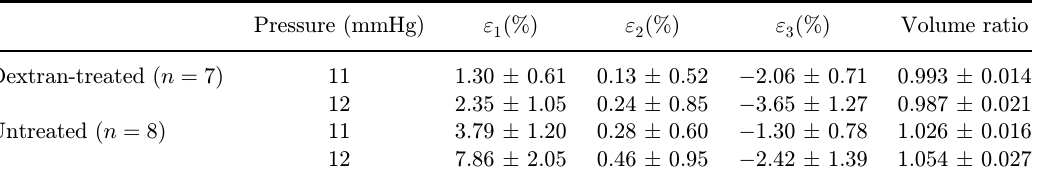
Table 1. Average principal strains ( " 1 , " 2 , " 3 ,) and volume ratio in porcine